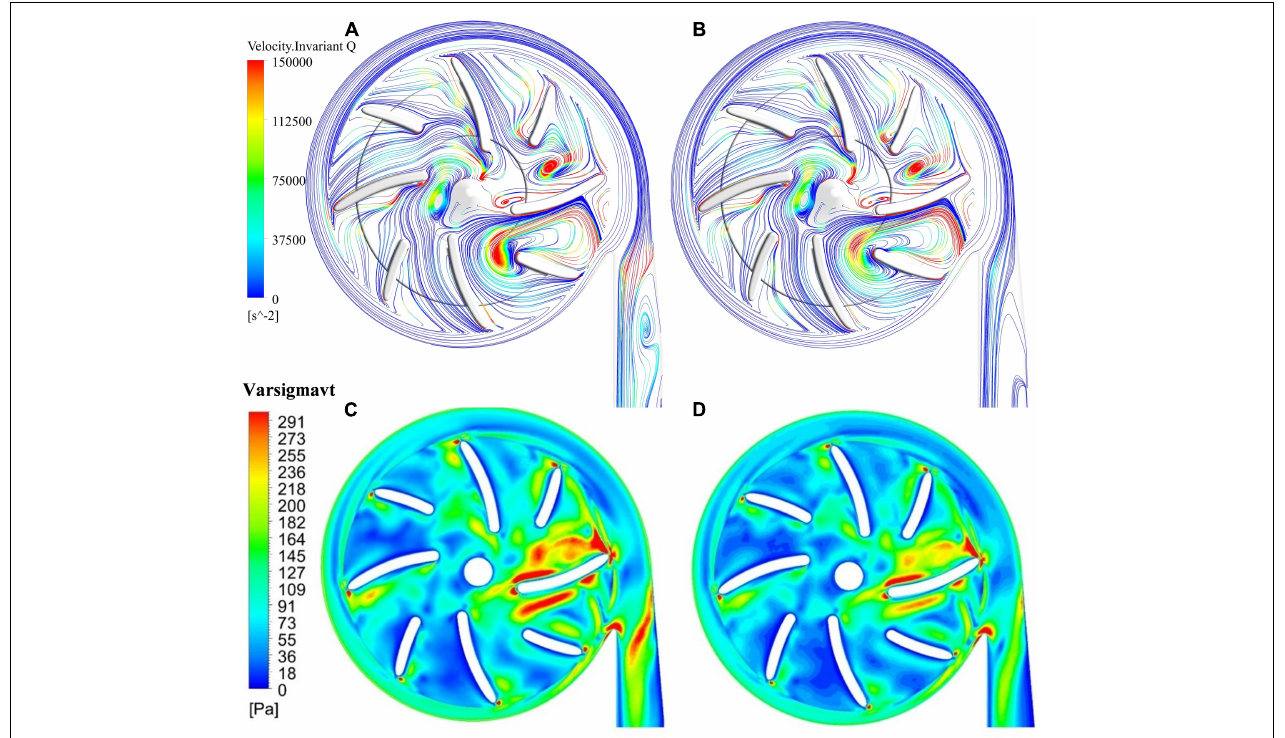
FIGURE 7 | Streamlines, colored by invariant Q of velocity: (A) model 3 (radius of the leading edge of splitter blades (cid:56) = 15 mm); (B) model 4 ( (cid:56) = 13.5 mm); contours of effective stress: (C) model 3; (D) model 4.